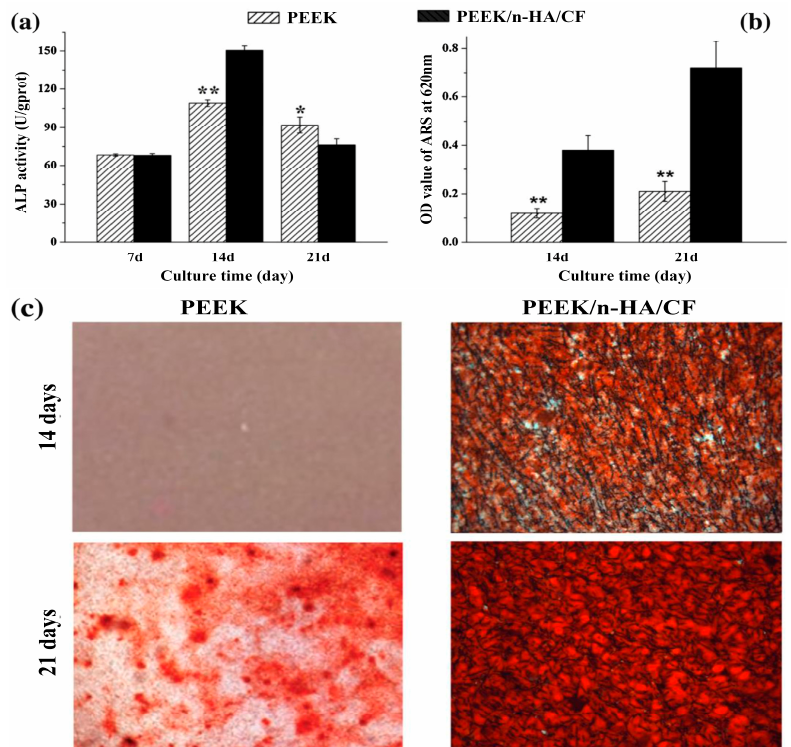
Figure 27. ( a ) ALP activity normalized to protein content of MG63 cells cultured on pure PEEK and PEEK/nHA-SCF hybrid for different time points. ( b ) The quantitative value of matrix mineralization acquired by measuring optical density. ( c ) Alizarin red staining for calcium-rich deposits secreted by MG63 cells on PEEK and PEEK/nHA-SCF hybrid. * represents p < 0.05 and ** indicates p < 0.01 compared with PEEK/nHA-SCF. Reproduced from [200] with permission of